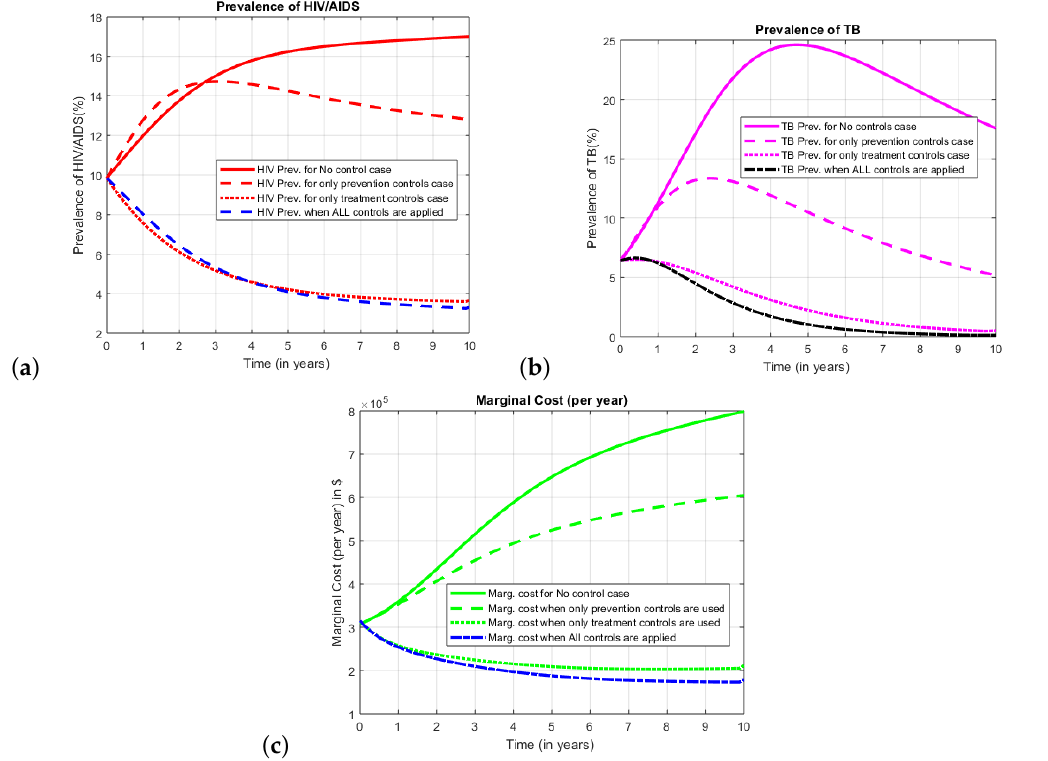
Figure 3. Graphs for the prevalence of ( a ) HIV and ( b ) TB and the corresponding values for the marginal cost in ( c ), when various combinations of control efforts are applied. All the parameter values are as described in the caption of Figure